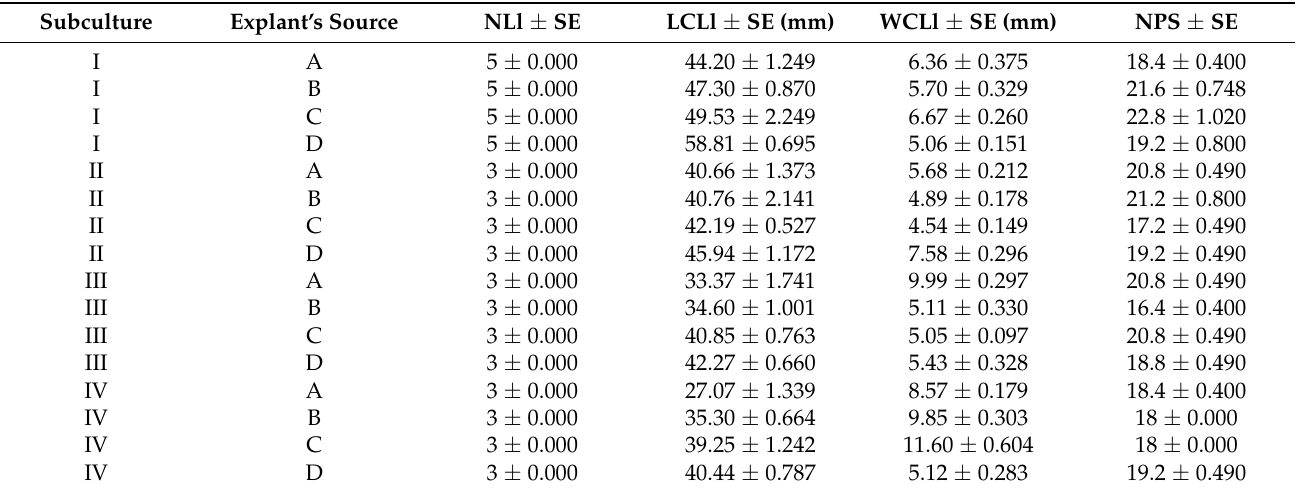
middle part; D: explant derived from apical part; LCLl: length of central leaflet; NLl: number of